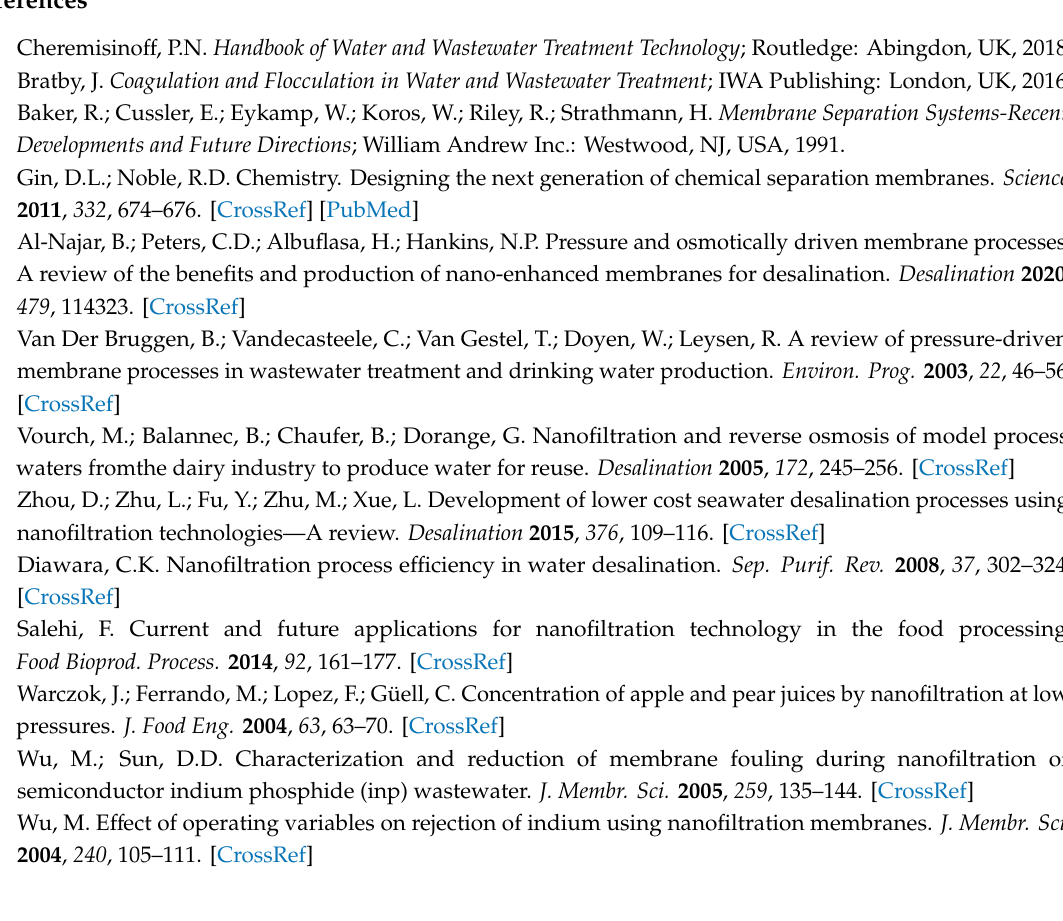
Figure S1: Dispersion of Na-MMT and O-MMT in n-hexane, Table S1: Surface area, total pore volume and pore size of